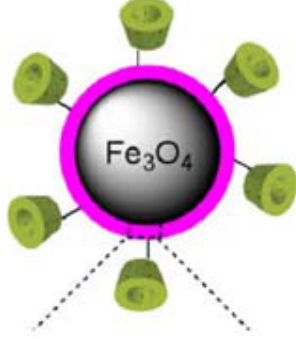
Figure 1. β -CD-functionalized magnetic nanoparticles ( β -CD-PDA-MNPs) [43]. © 2017 Elsevier B.V.